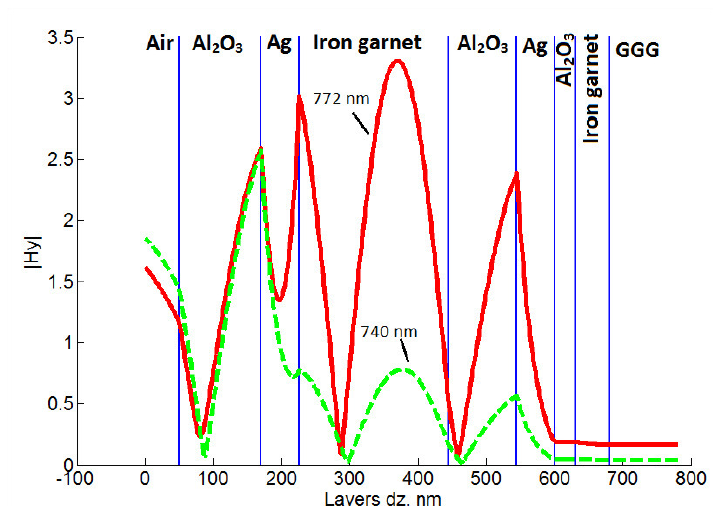
Figure 6. |H | component of light field intensity distribution for the sample-4: At the y resonance wavelength of 772 nm (solid red line) and at the non-resonant wavelength of 740 nm (dash green line).